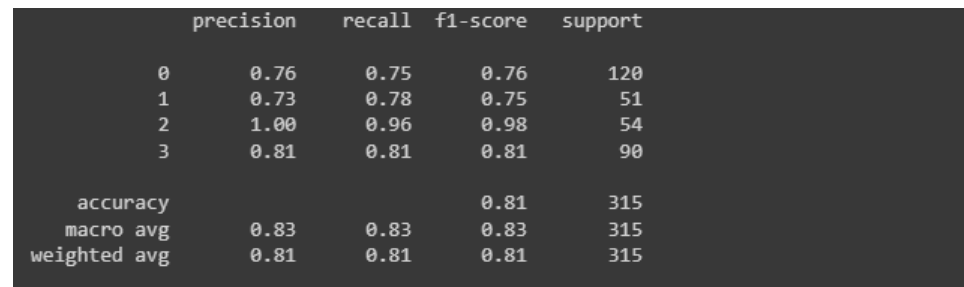
Figure 14. Classification report for the second model.